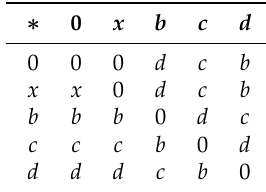
Table 2. Cayley table for the binary operation “ ∗